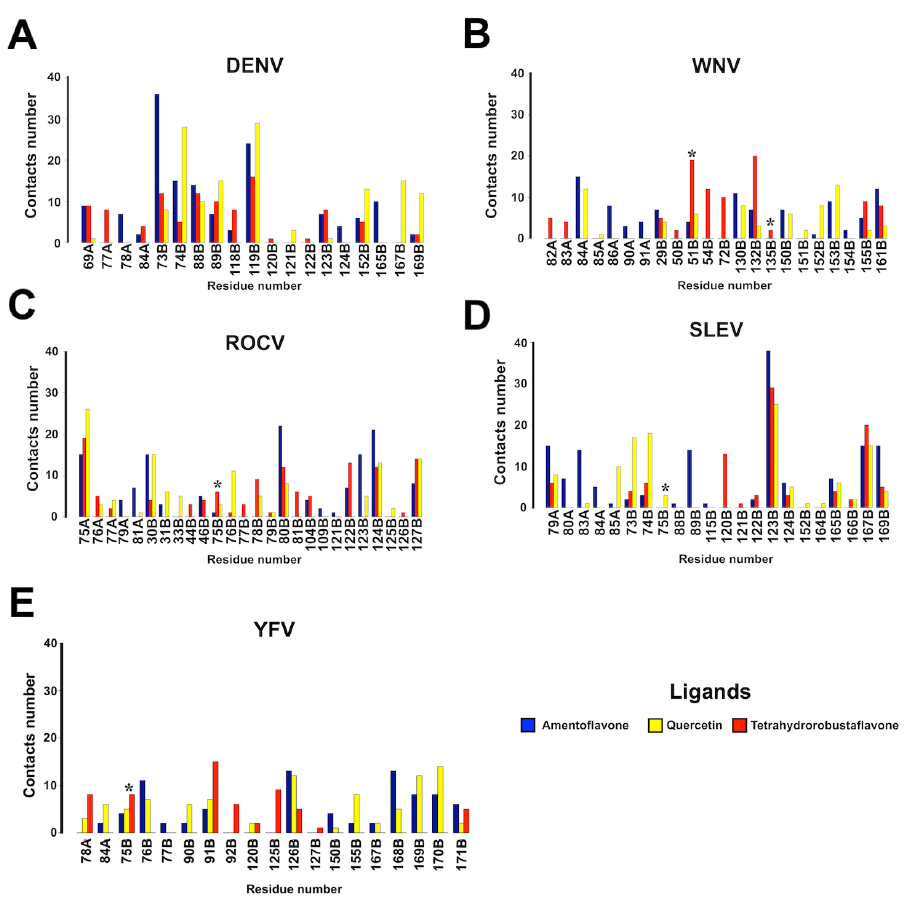
Figure 6. Bar graph of the number of contacts per residue of the NS2B–NS3pro protein complex of ( A ) dengue virus (DENV), ( B ) West Nile virus (WNV), ( C ) Rocio virus (ROCV), ( D ) Saint Louis encephalitis virus (SLEV), and ( E ) yellow fever virus (YFV). Chain A (NS2B) and chain B (NS3pro). * Residues from active site